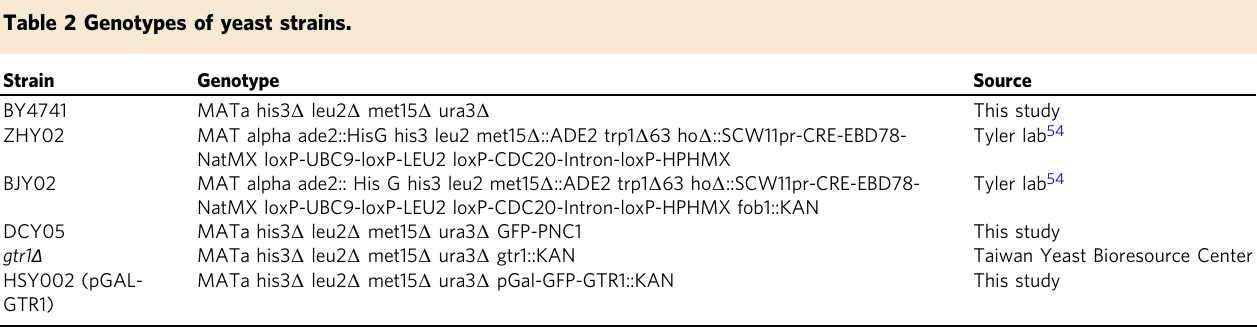
Fig. 7 Corylin prolongs lifespan in aged HFD-fed mice. Forty-week-old male mice were fed a HFD with or without corylin treatment ( n = 30 per group). a Survival curves of mice fed a HFD versus 1%(v/v) corylin (HFD/C) show a signi fi cant (Gehan – Breslow – Wilcoxon test χ 2 = 4.887 and p = 0.0271) improving lifespan. b , c The bodyweight of mice after started fed with HFD or HFD/C and food consumption (The start point to fed corylin indicated by a black arrow, n = 30 at start point). d Circulating level of corylin ( n = 4 biologically independent samples). e Rearing behavior was analyzed in obese mice fed a HFD with or without corylin for 35 weeks under dim and bright light conditions (HFD: n = 6; HFD/C n = 9 biologically independent animals). Latency to falling in the f constant rotarod and (HFD: n = 10; HFD/C: n = 8 biologically independent animals) g accelerating rotarod tests (HFD: n = 7; HFD/C: n = 5 biologically independent animals). h Western of total muscle for Phospho-mTOR Ser2448 (P-mTOR), total-mTOR (T-mTOR) and β -Actin ( n = 3). i Quanti fi cation was normalized with T-mTOR ( n = 3 biologically independent samples). j Fasting blood glucose level result ( n = 9 biologically independent samples, p = 0.0058). k Serum biochemical marker results ( n = 5 biologically independent samples, total cholesterol p = 0.0037, low-density lipoprotein p = 0.0151, triglyceride p = 0.0486, aspartate transaminase p = 0.0006, creatinine p <0.0001). Values are expressed as the mean±SEM. a p values were determined by the Gehan – Breslow – Wilcoxon test. e – g , i – k p values were determined by two-tailed unpaired Student ’ s t -test. Source data are provided as a source data fi le.